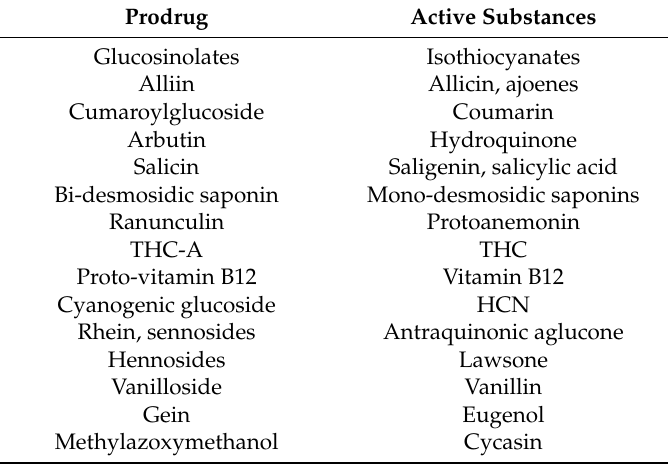
Table 1. Examples of plant